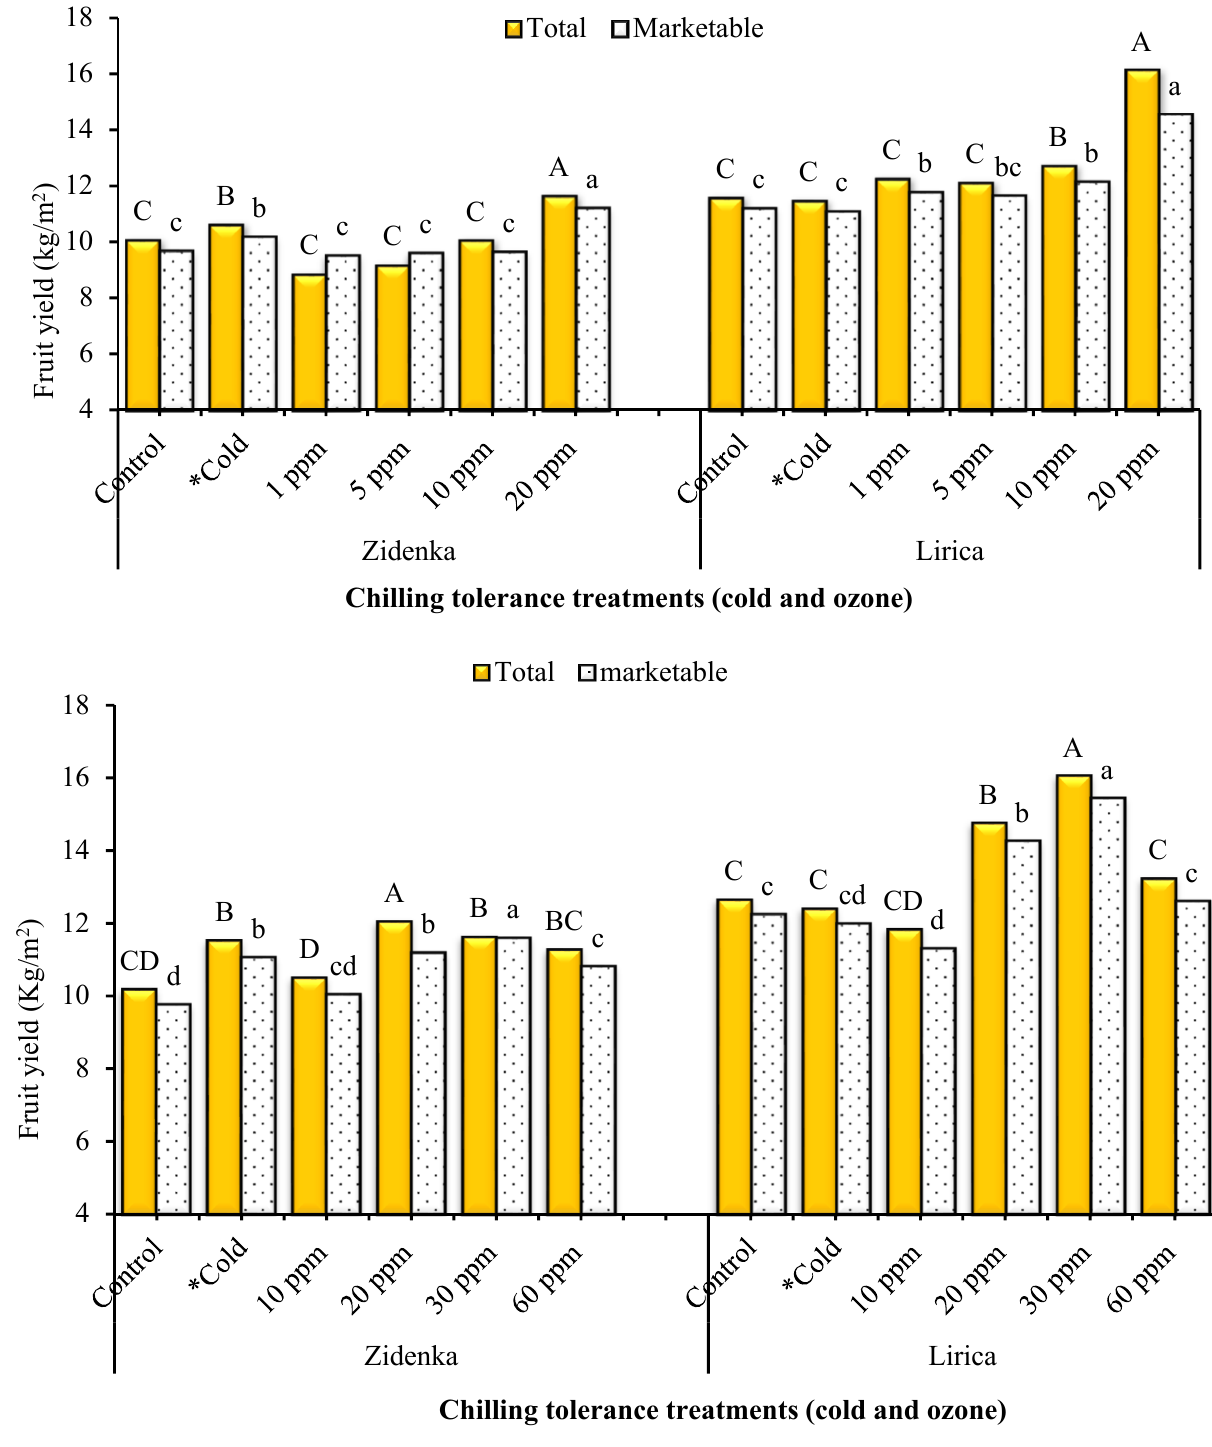
Figure 6. Effect of seed soaking in different ozonated water concentrations and cold pretreatments on total and marketable fruit yields of two sweet pepper hybrids during the 2017/2018 (upper figure) and 2018/2019 (lower figure) seasons. The columns labeled with different letters with in the same case are significantly different according to Duncan’s multiple range test at 0.05 levels. * Cold stress treatment was performed at 4 °C for 36 h.